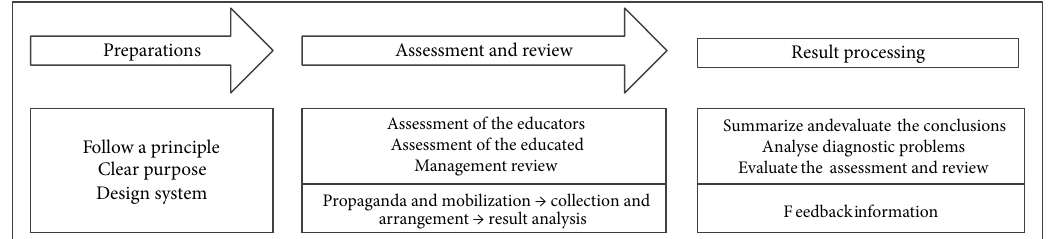
Figure 6. Process model for the assessment and review of the safety education